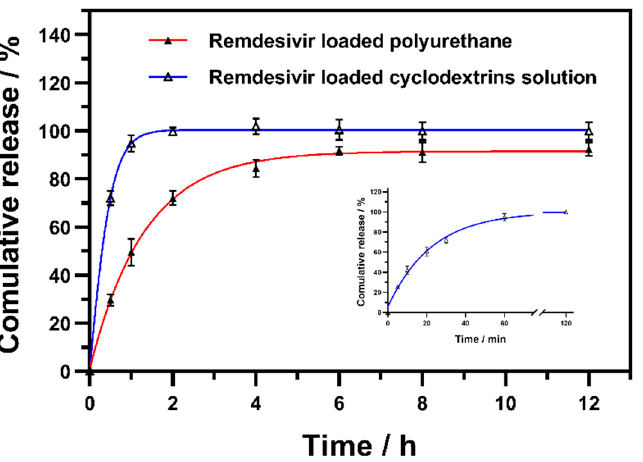
Figure 5. In vitro RDV release profiles of thermogel and cyclodextrin inclusion complex in artificial tears.